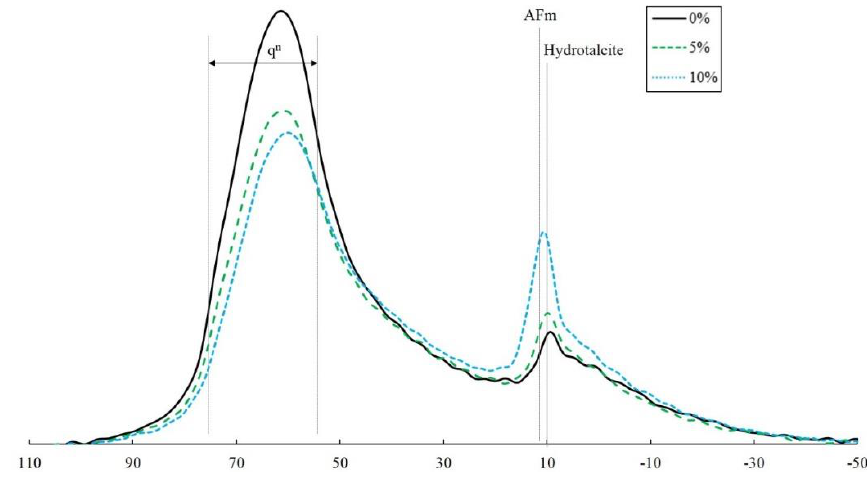
Figure 6. 27 Al nuclear magnetic resonance (NMR) of the specimens on the 28th day.